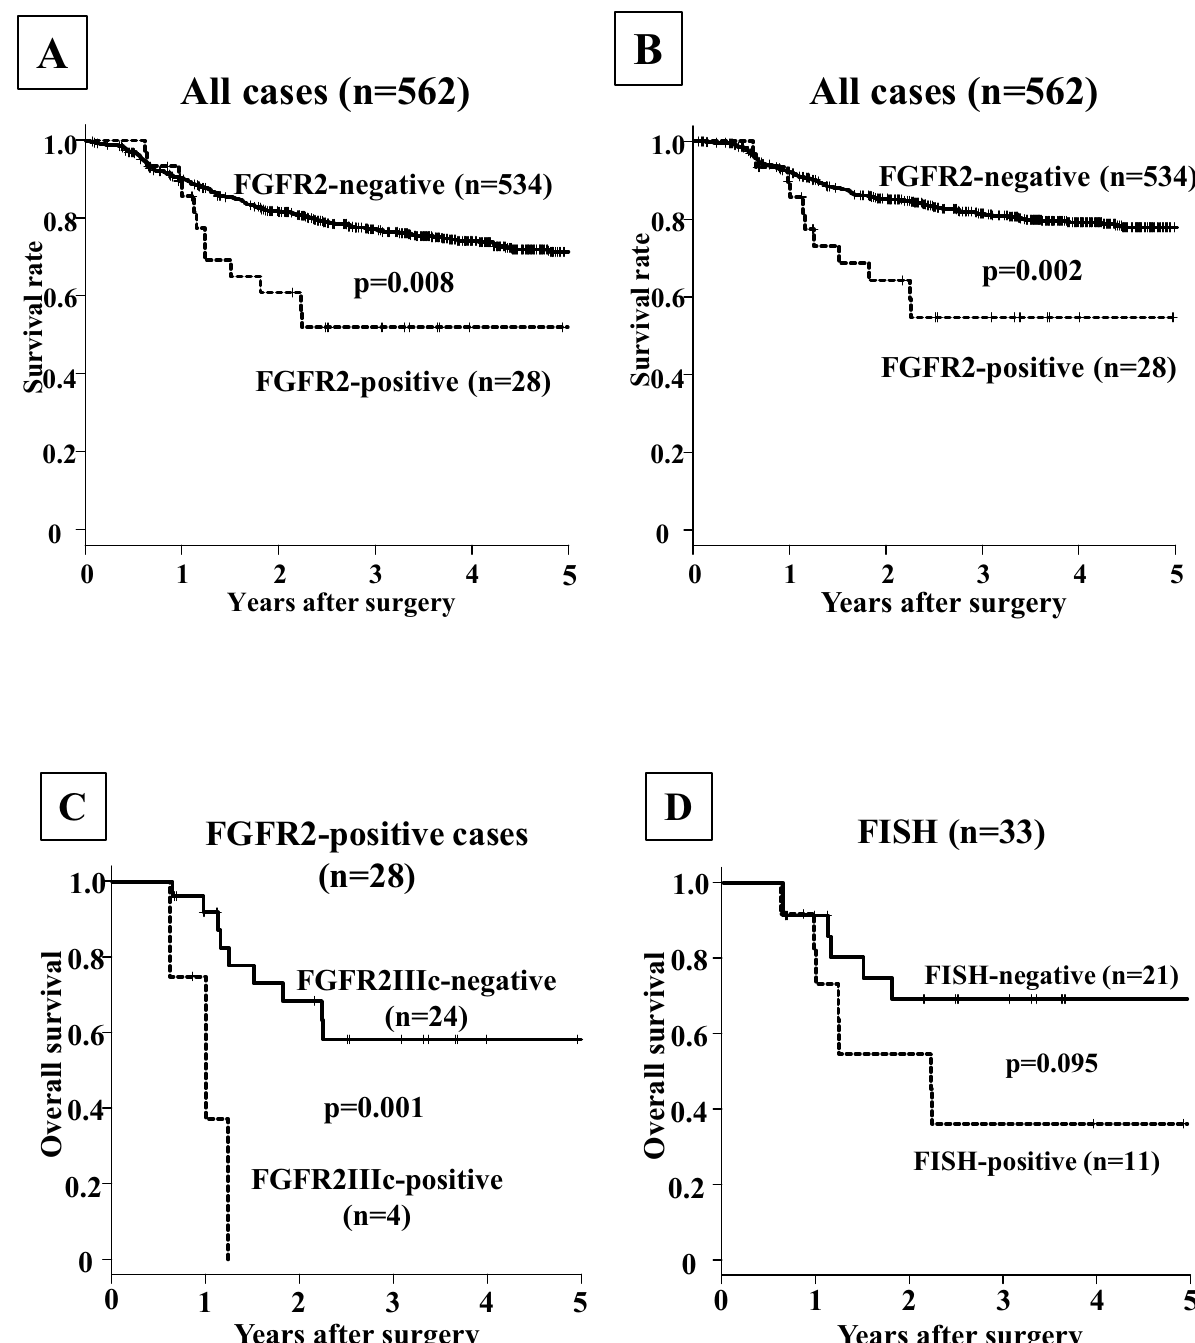
Figure 3. Survival curve. ( A ) Overall survival of patients with FGFR2IIIb-positive tumor was significantly poorer (p = 0.008) than that of patients with FGFR2IIIb-negative tumor. ( B ) Disease specific survival of patients with FGFR2IIIb-positive tumor was significantly poorer (p = 0.002) than that of patients with FGFR2IIIb- negative tumor. ( C ) In patients with FGFR2-positive tumor, overall survival of patients with FGFR2IIIc-positive tumor was significantly (p = 0.003) poorer than that with FGFR2IIIc-negative. ( D ) FGFR2 amplification tended to be associated with a poorer outcome, compared with non-amplified cases (p =